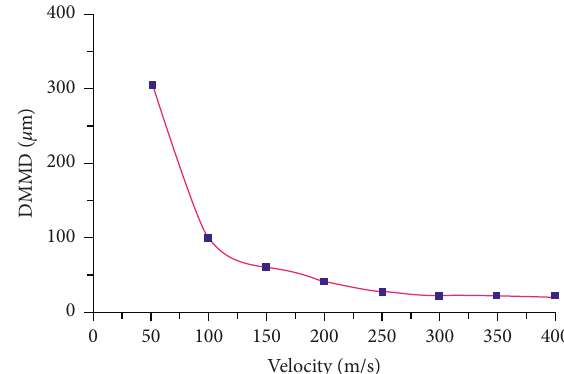
Figure 3: Dependence of the mass mean diameter and the speed of entry into the chamber.